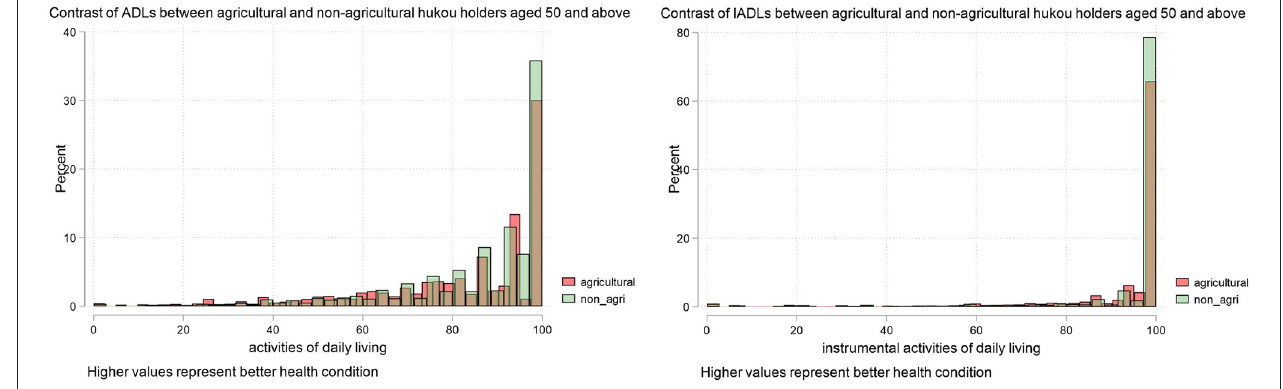
FIGURE 1 | Contrast of health status between non-agricultural and agricultural hukou holders (left: ADLs index; right: IADLs index; samples have been restricted to those who are Han majority, and aged 50 and above).